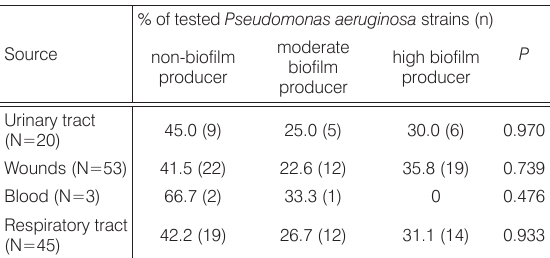
Table 6. Biofilm Production of Pseudomonas aeruginosa Strains Recovered From Various